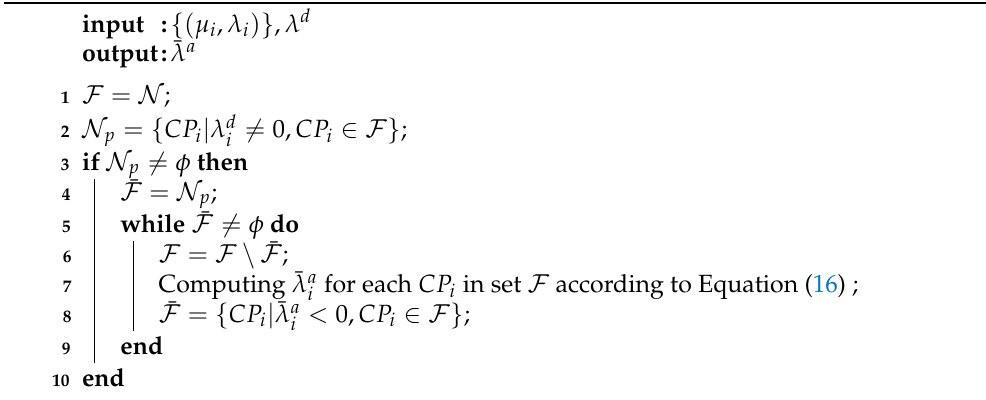
Algorithm 1: Service request allocation algorithm in